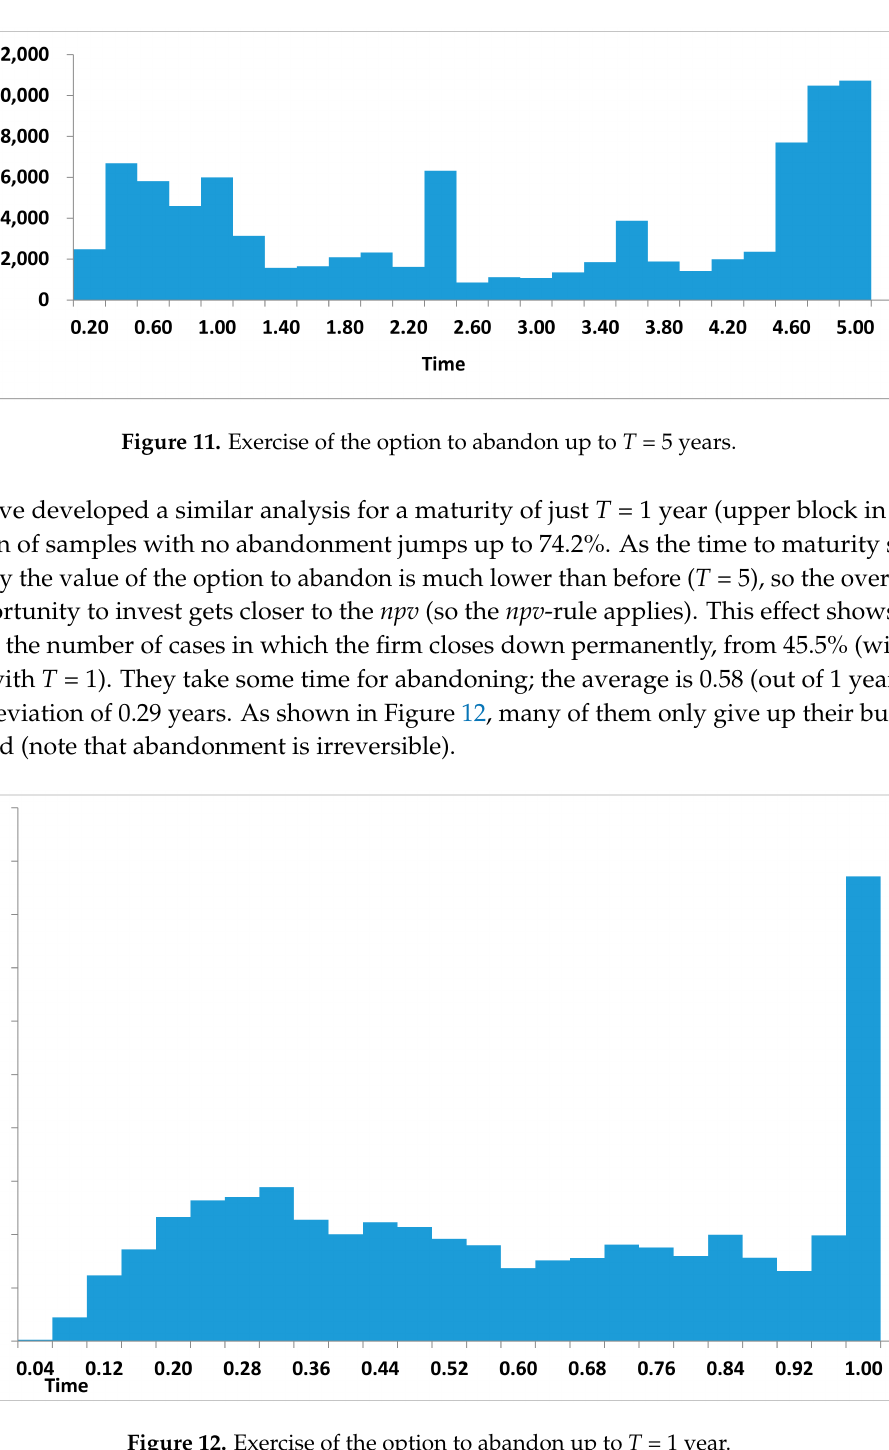
Figure 12. Exercise of the option to abandon up to T = 1